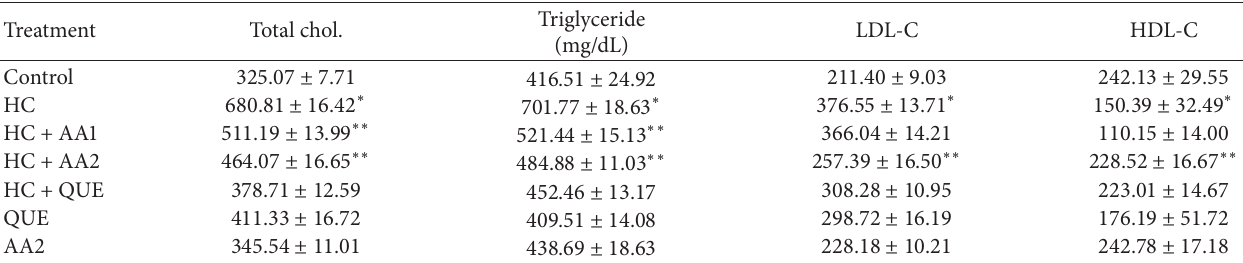
Values are means ± SD of 5 animals per group; HC: cholesterol at 30mg/0.3mL. AA1: Artocarpus altilis at 100mg/kg, AA2: Artocarpus altilis at 200mg/kg, and QUE: Questran at 0.26g/kg, ∗ Significantly different from control ( 𝑃 < 0.05 ). ∗∗ Significantly different from HC ( 𝑃 < 0.05 ). Table 7: Changes in antiatherogenic, coronary risk, and cardioprotective indices of hypercholesterolemic rats treated with methanol extract of Artocarpus altilis and Questran for nine weeks.